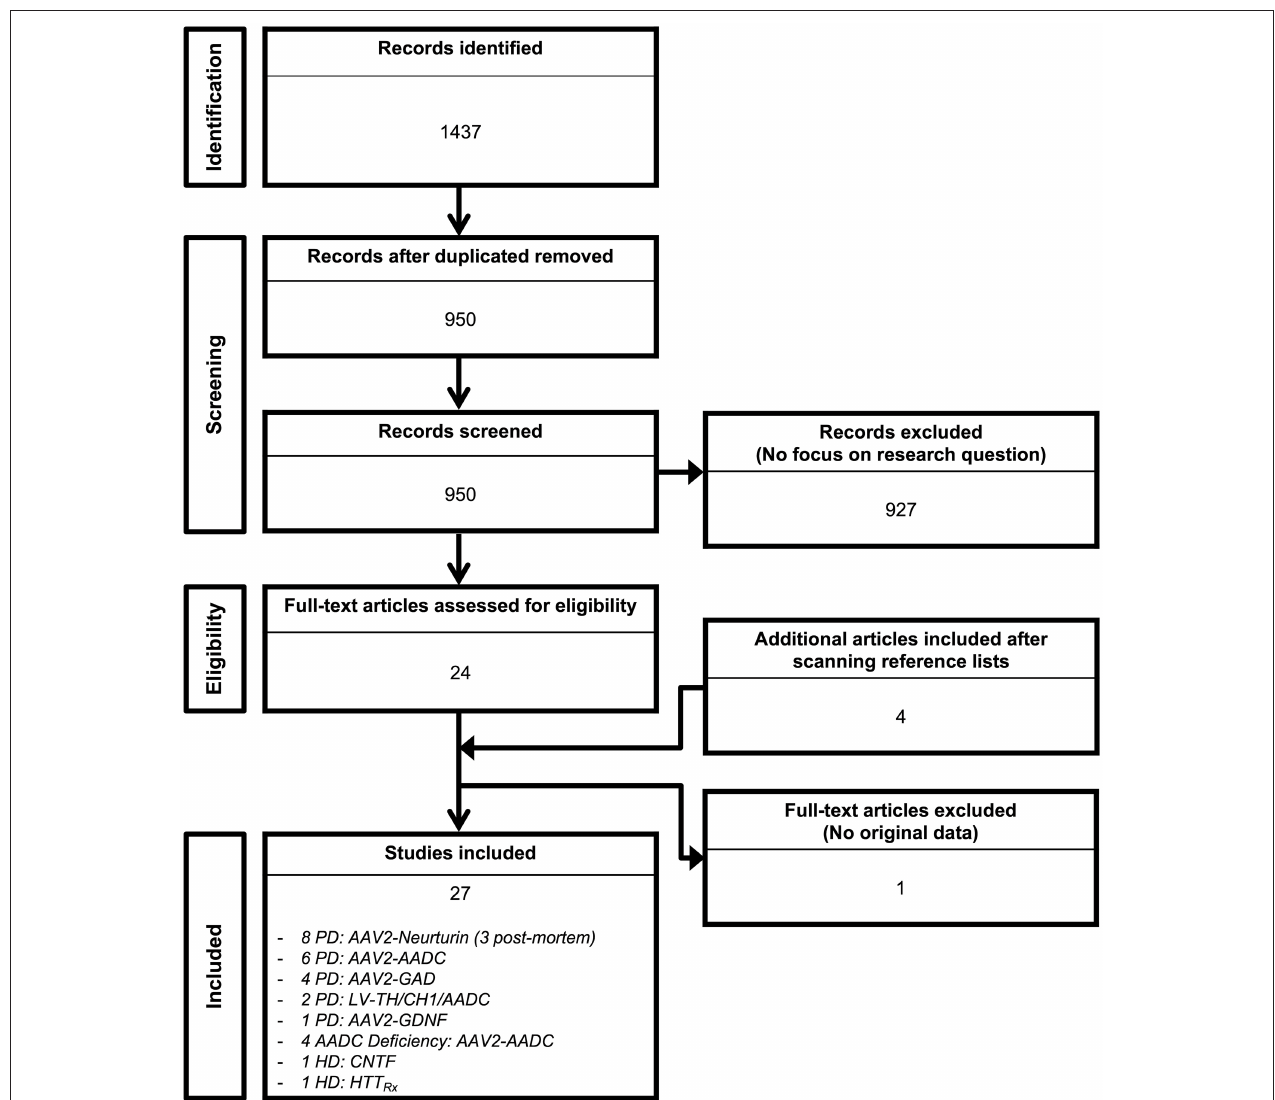
FIGURE 1 | Search flow diagram. Graphical representation of the studies identified, screened for eligibility, and included in the